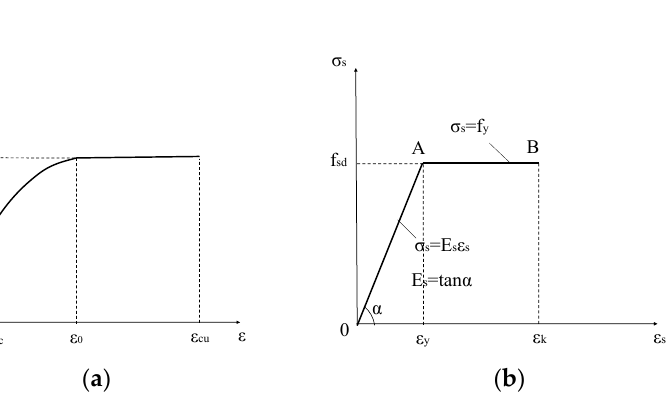
Figure 12. Stress–strain relationship of reinforced concrete structural materials. ( a ) Compression of concrete, ( b ) rebar in tension.